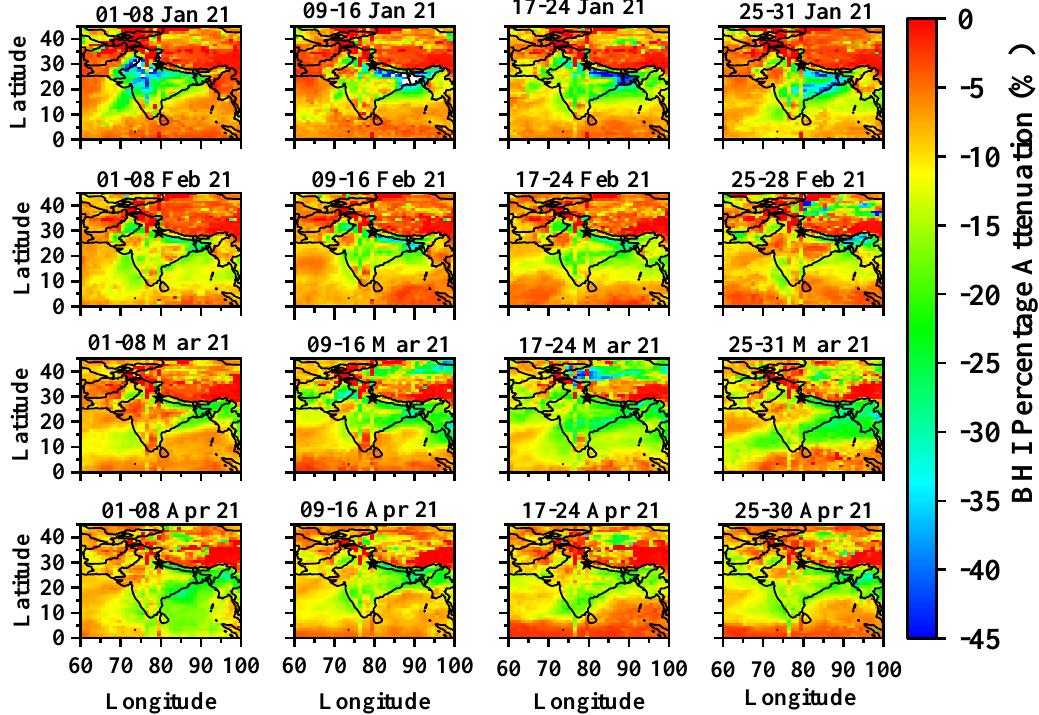
Figure 8. Weekly average maps of BHI percentage attenuation over the Indian subcontinent during the period of January to April 2021.